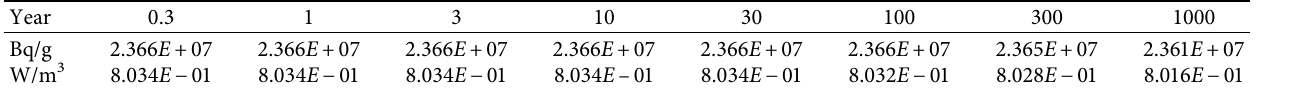
Table 11: Radiological characteristics of Se waste/waste